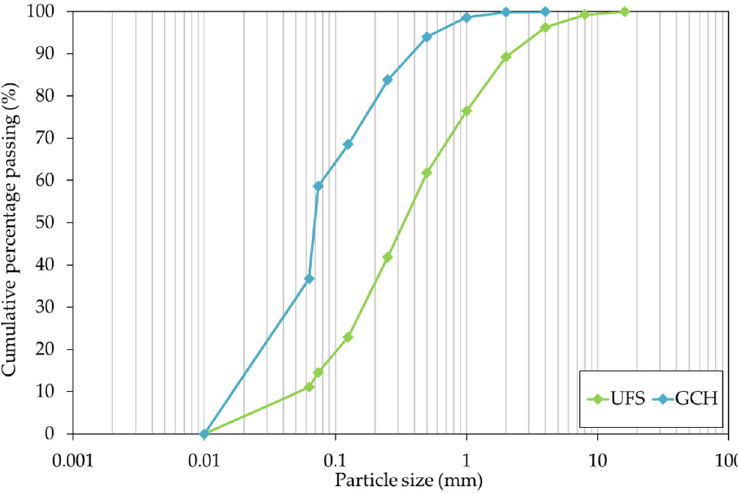
Figure 3. Particle size distribution of UFS and GCH before the grinding and sieving processes.